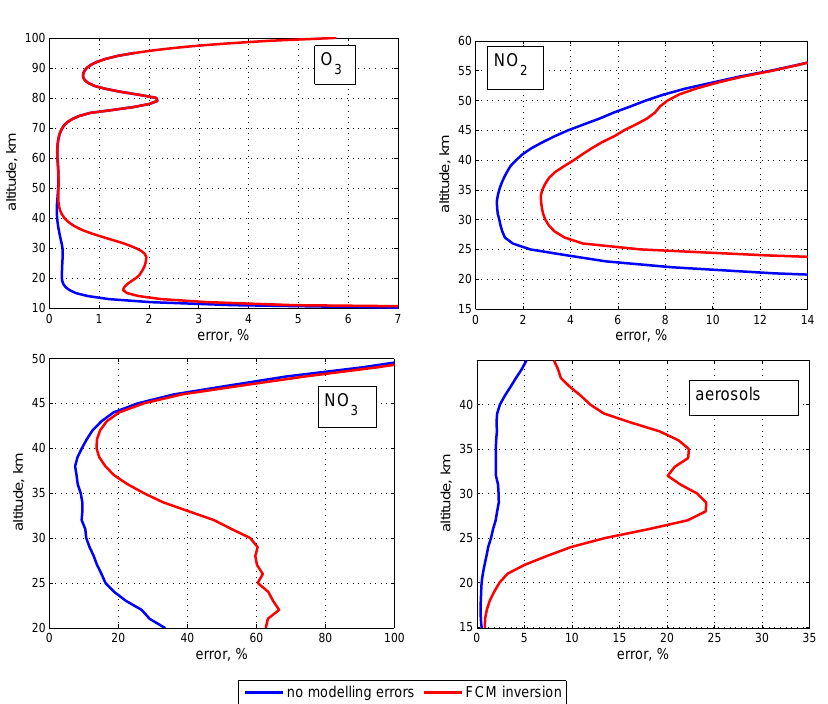
Figure 4. As Fig.1, but for local density profiles. Fig. 4. As Fig. 1, but for local density profiles.